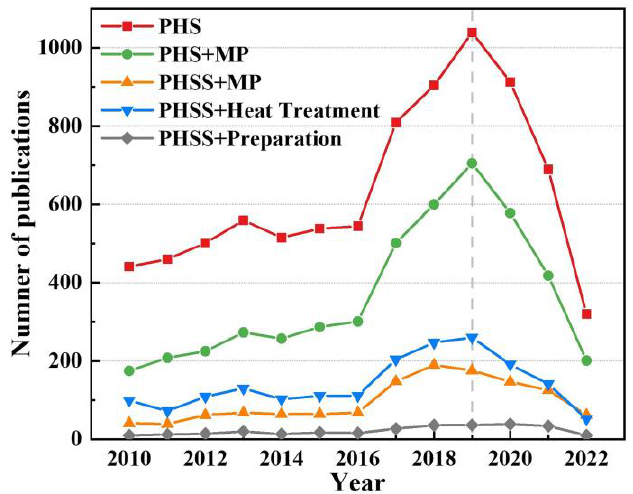
Figure 1. Number of precipitation hardening stainless steel publications per year with microstructure-properties, heat treatment, and preparation since 2010 (data from Web of Science database until 16 September 2022).